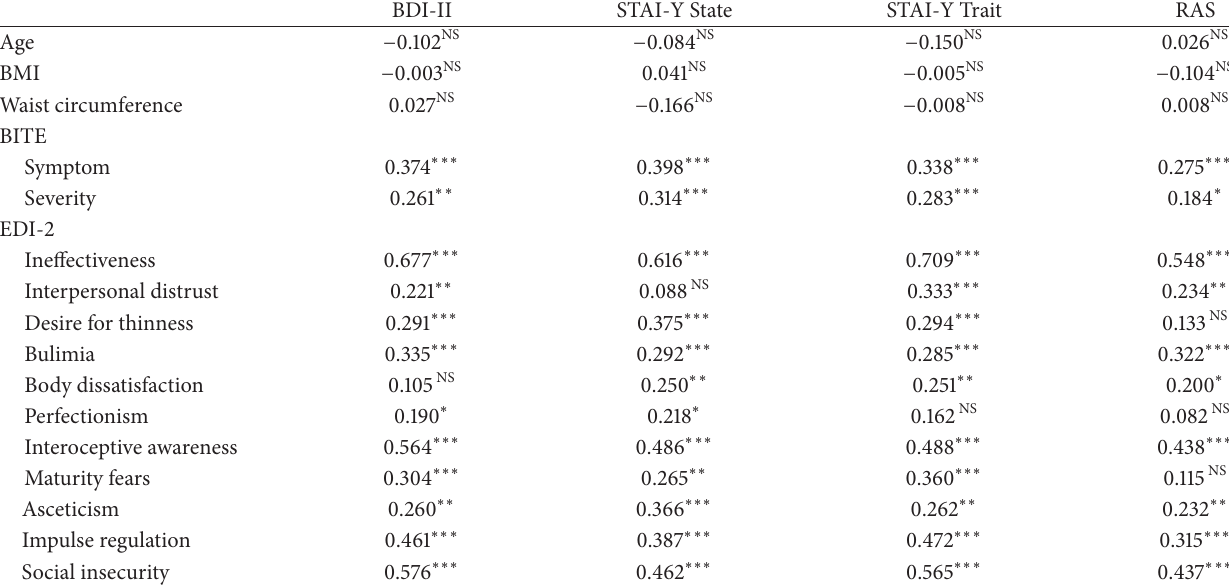
Table 2: Spearman’s correlations between anthropometric parameters, eating behaviour, and psychological